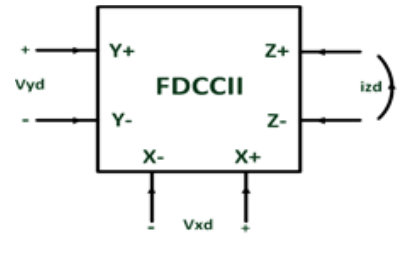
Figure 1. Block diagram of